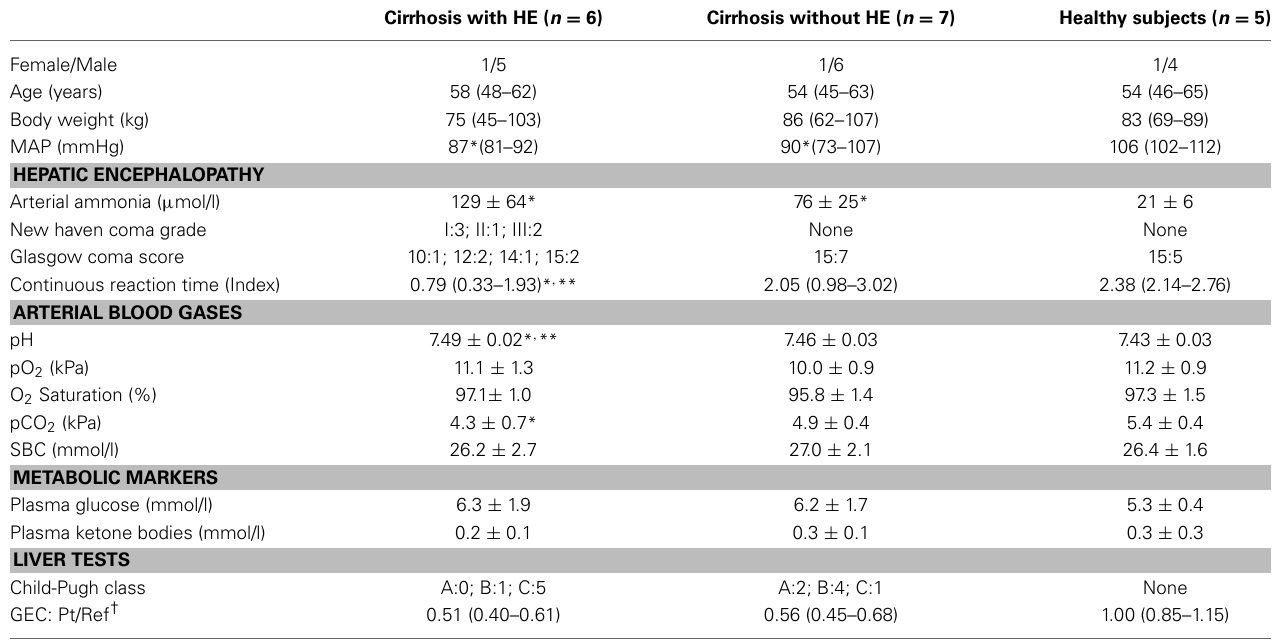
Table 1 | Patient Characteristics (revised from Iversen et al., 2009). Cirrhosis with HE ( n = 6) Cirrhosis without HE ( n = 7) Healthy subjects ( n =